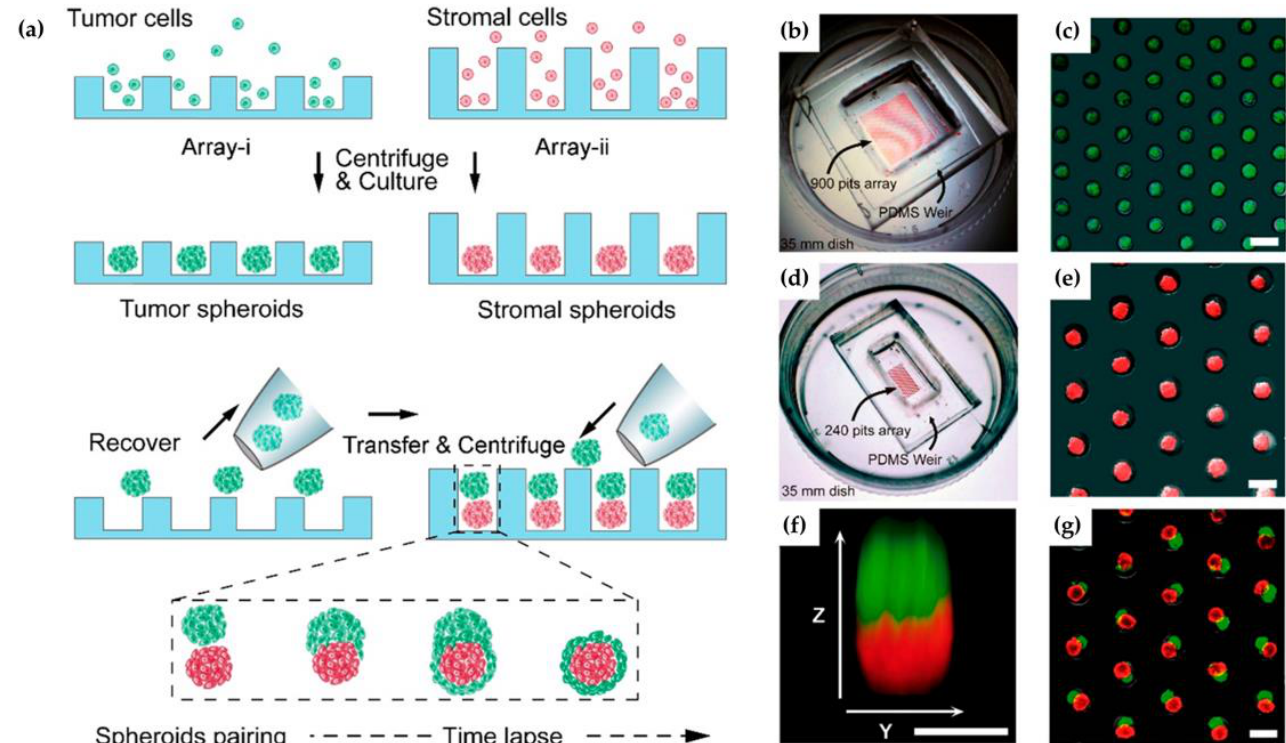
Figure 2. ( a ) The microfluidic micro well array-based spheroids pairing; ( b – e ) representative pictures of chips; ( f ) tu- mor−stroma pairing with green and red fluorescence; and, ( g ) image of heterotypic cell spheroid pairs [80].